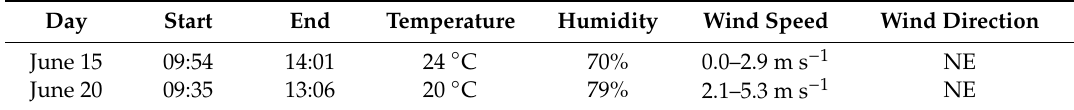
Table 1. Environmental conditions summary of the experiment Table 1 . Environmental conditions summary of the experiment days.